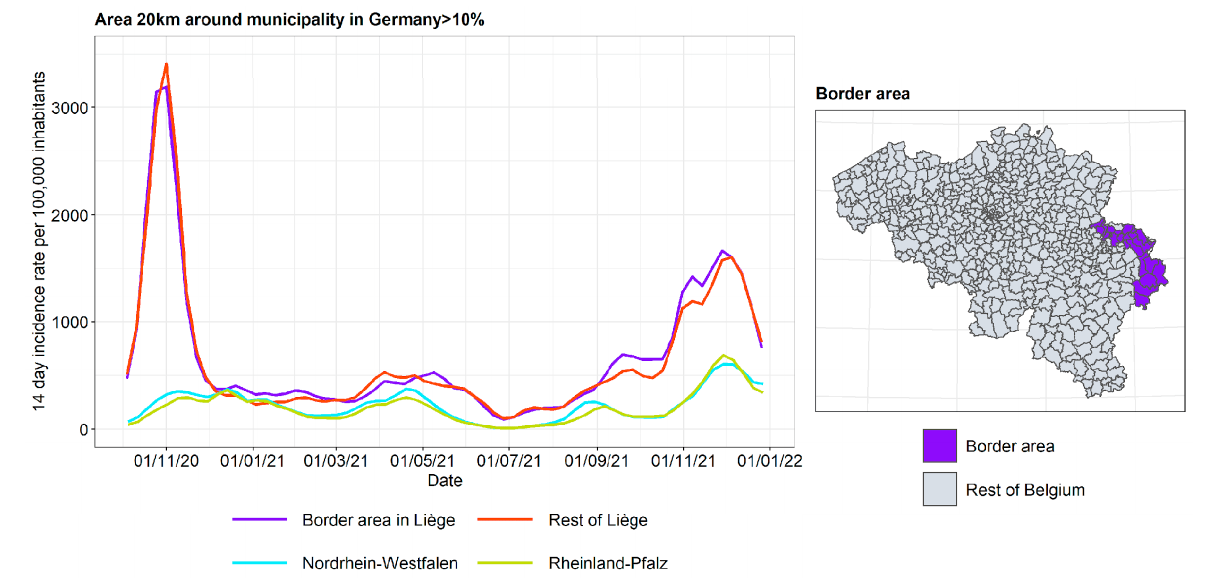
Figure 15. COVID-19 incidence for the border area with Germany.